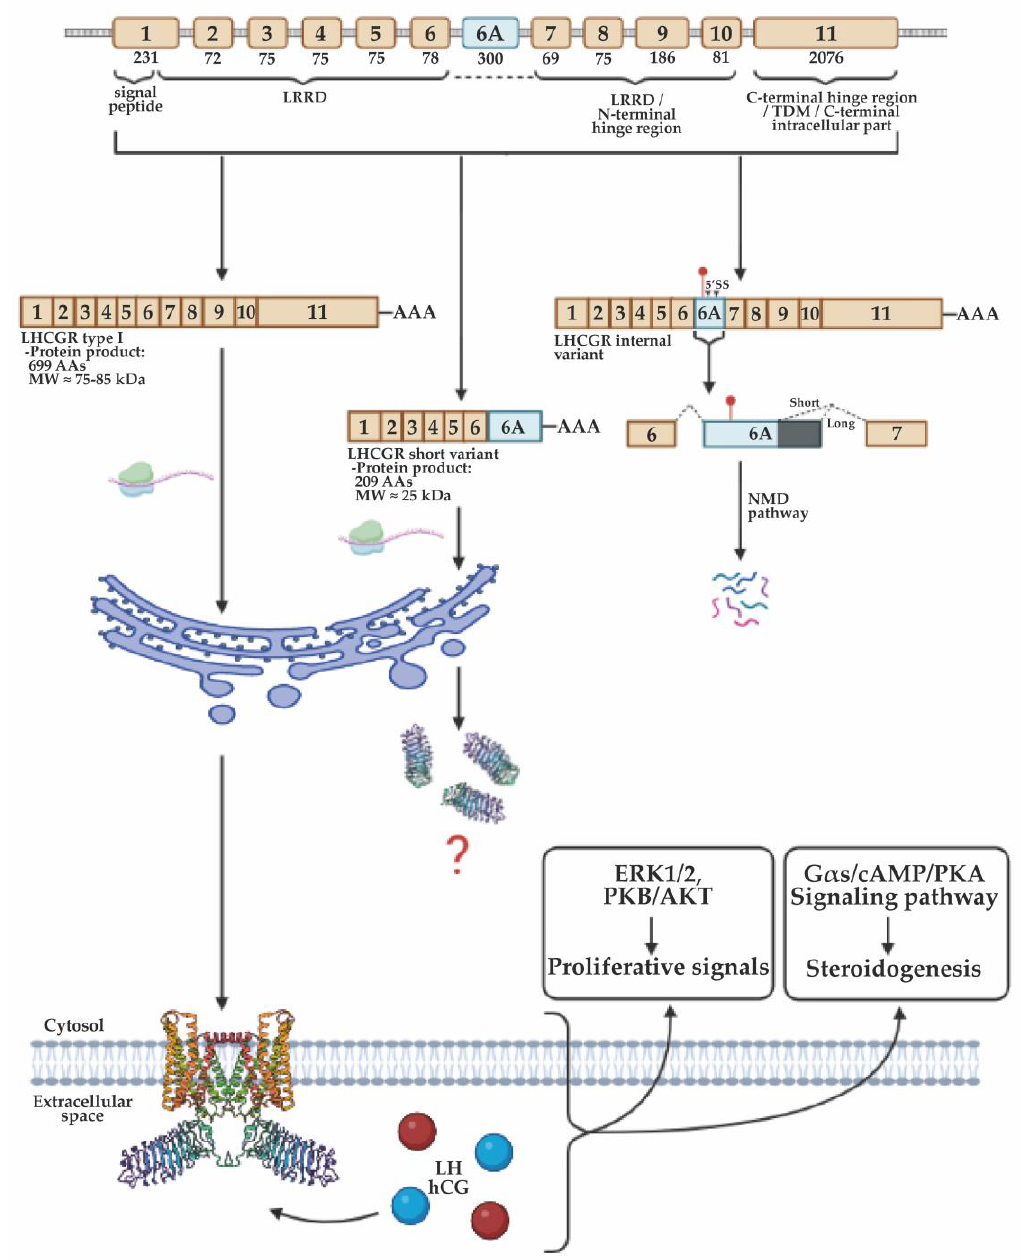
Figure 1. Transcription and translation of LHCGR variants. From top to bottom, we graphically report the complete LHCGR gene assembly, the putative transcriptional model, and the receptor structure/signaling pathways activated by LHCGR. In the schematic representation of the internal variant, the red spot indicates the translational stop codon, while 5′ SS indicates the two 5′ splicing sites that give rise to the internal-short and internal-long variants, both degraded by nonsense-me- diated mRNA decay (NMD) pathway. The 3D monomeric LHCGR structural models, here reported as dimer on the cellular surface, have been uploaded from Protein Data Bank (protein #7FIJ).